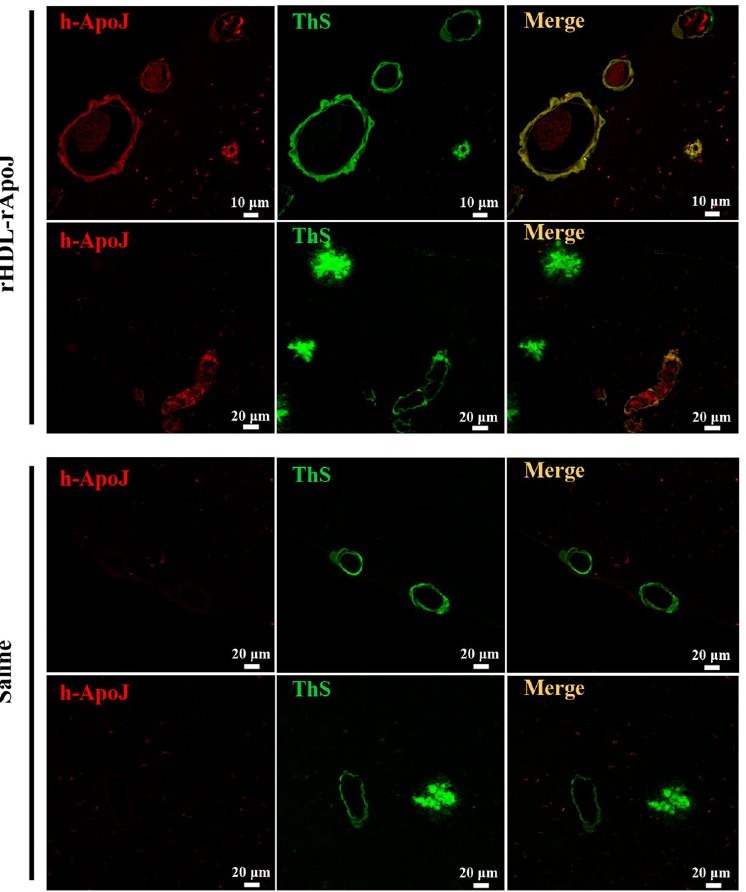
Figure 7. Localization of human rApoJ in brain after IV administration of rHDL-rApoJ nanodiscs in APP23 mice. Double labelling of human rApoJ (rApoJ in red) and fibrillary A β (ThS in green) in old APP23 animals treated with 1 mg/kg of rHDL-rApoJ nanodiscs or saline. Co-localization of rApoJ and fibrillary A β is observed in merged images